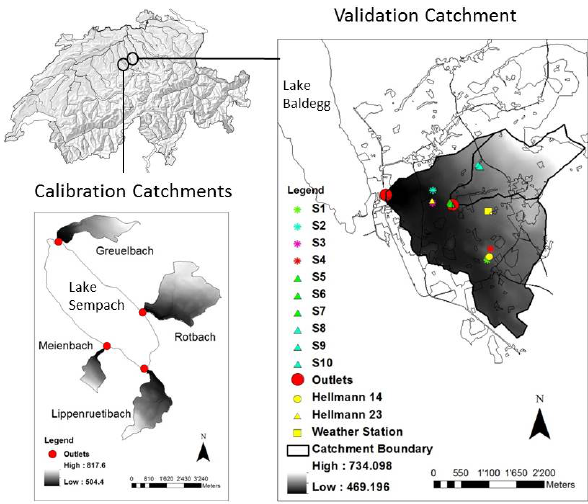
Fig. 1. Locations of calibration and validation catchments and the installed measurement